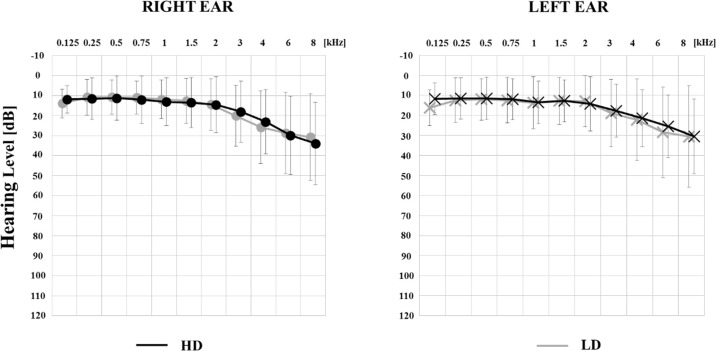
Audiograms: Average left and right ear hearing thresholds in the high tinnitus-related (HD) and low tinnitus-related (LD) distress groups.Errors bars show standard deviations of the individual means.